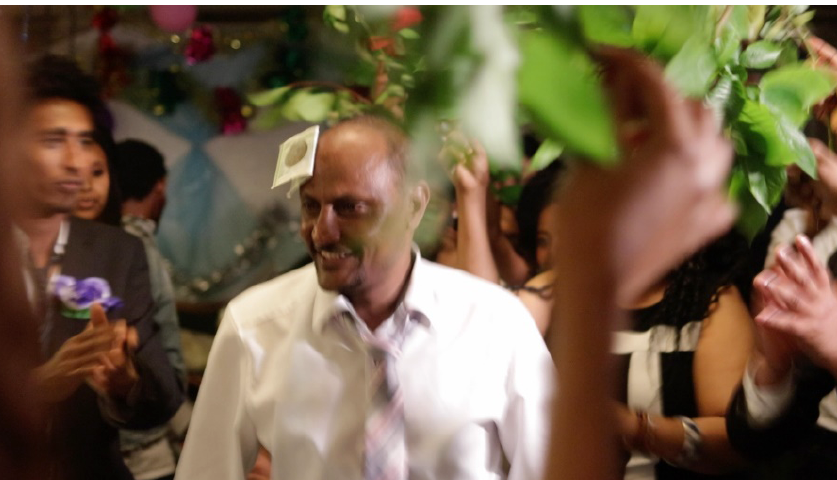
Figure 9. The Eritrean community in Hannebjerg hosted a wedding. During the evening, it was evident how closely con- nected the various Eritrean communities in Denmark and abroad are, as people came from far away. The evening was full of festivities and the home transformed with long tables, a podium for the married couple, a stage for music, flags, balloons and flowers. Rituals were performed throughout the evening. One of the final performances was the dance of the groom, where the surrounding participants attached 100 and 200 DKK bills to his forehead. May 2017.